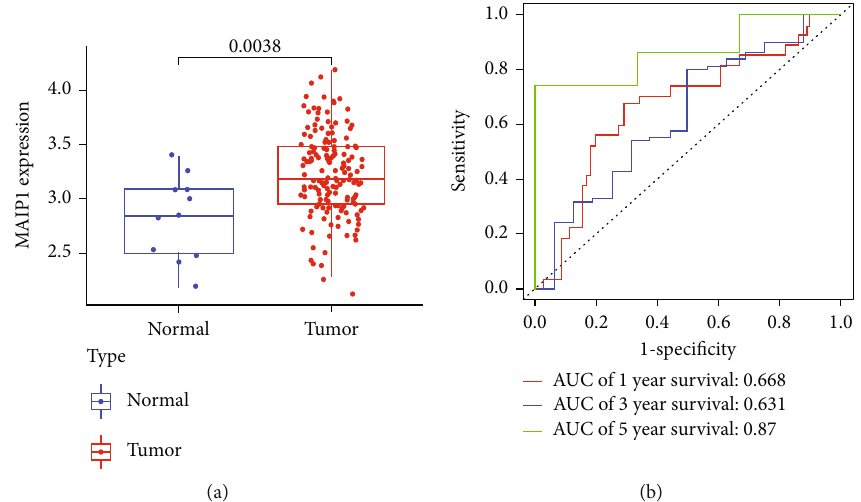
Figure 1: Expression and diagnosis value of MAIP1 in EC. (a) Expression of MAIP1 between EC tissues and normal tissue based on TCGA datasets. (b) Receiver operating characteristic (ROC) curve of EC tissues and normal